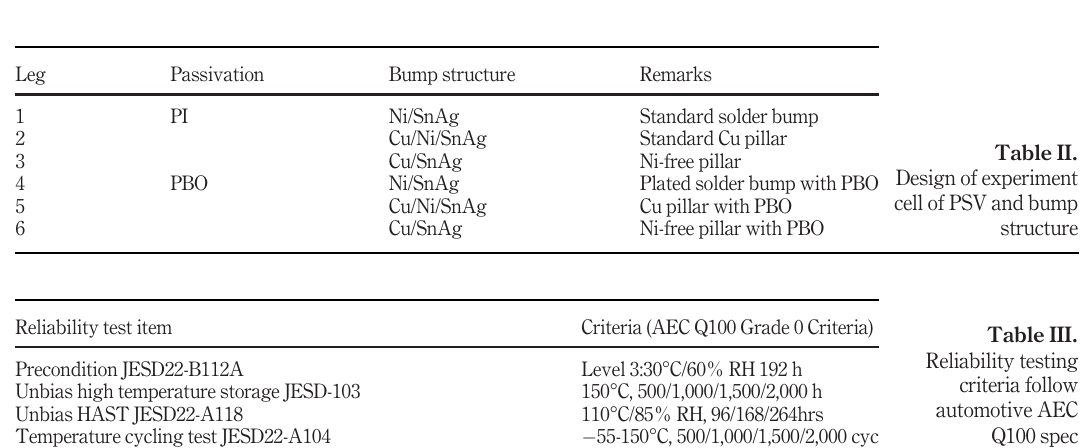
Table I. Con fi guration